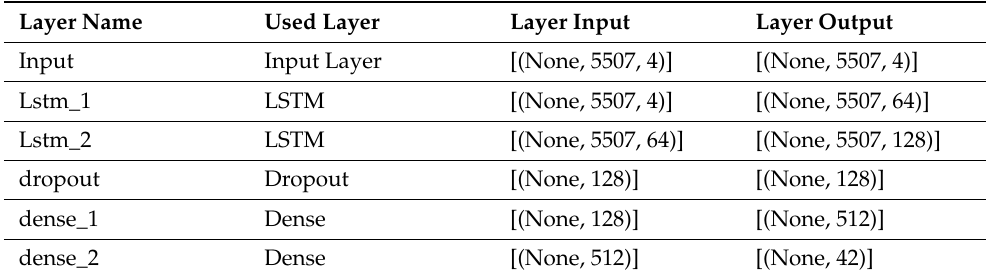
Table 1. LSTM architecture.